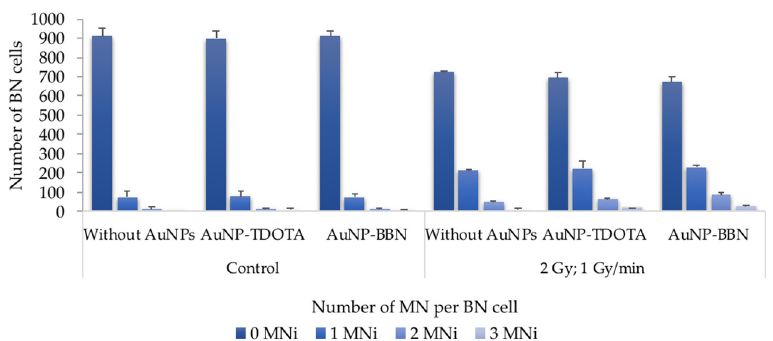
Figure 6. Average distribution of MNi per 1000 BN cells, 0, 1, 2 and 3 MNi, respectively, in PC3 cells irradiated with 2 Gy, following incubation with AuNP-TDOTA and AuNP-BBN at a concentration of 36 µg Au/mL and in PC3 control cells. The results were calculated from independent biological replicates ( n = 2) and are given as the mean ± S.E.M.